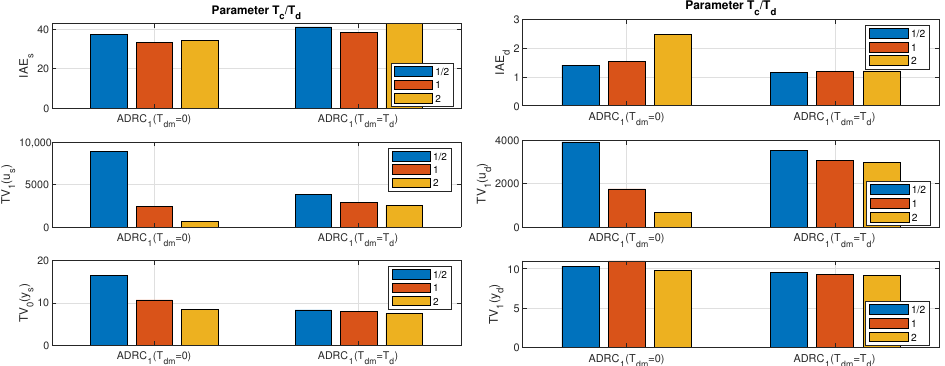
Figure 6. ADRC 1 : Performance measures corresponding to the controller in Figure 2 and transients in Figure 5 with the parameter T c , T dm = T d = 0 and T dm = T d = T d